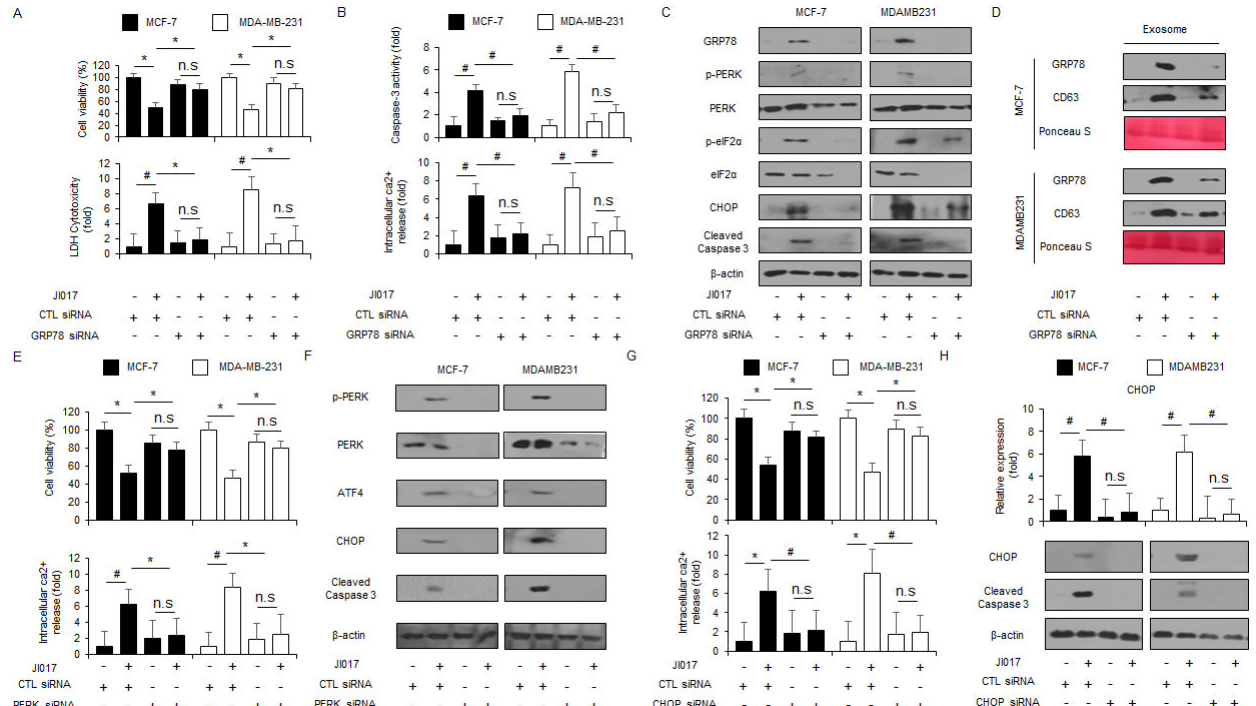
Figure 3. Targeting of ER stress signaling suppresses JI017-induced ER stress and cell death in breast cancer cells. ( A , B ) MCF-7 and MDA-MB-231 cells were transfected with GRP78-specific siRNA in the presence or absence of JI017 (300 µg/mL, 24 h) and WST-1, LDH, caspase-3 activity, and intracellular Ca 2+ assay were performed; *, p < 0.05, #, p < 0.01. ( C ) Western blot analysis of GRP78, p-PERK, PERK, p-eIF2α, eIF2α, ATF4, CHOP, and cleaved caspase-3 in JI017 (300 µg/mL, 24 h)-treated MCF-7 and MDA-MB-231 cells in the presence or absence of GRP78 siRNA (30 nM, 24 h). β-actin was used